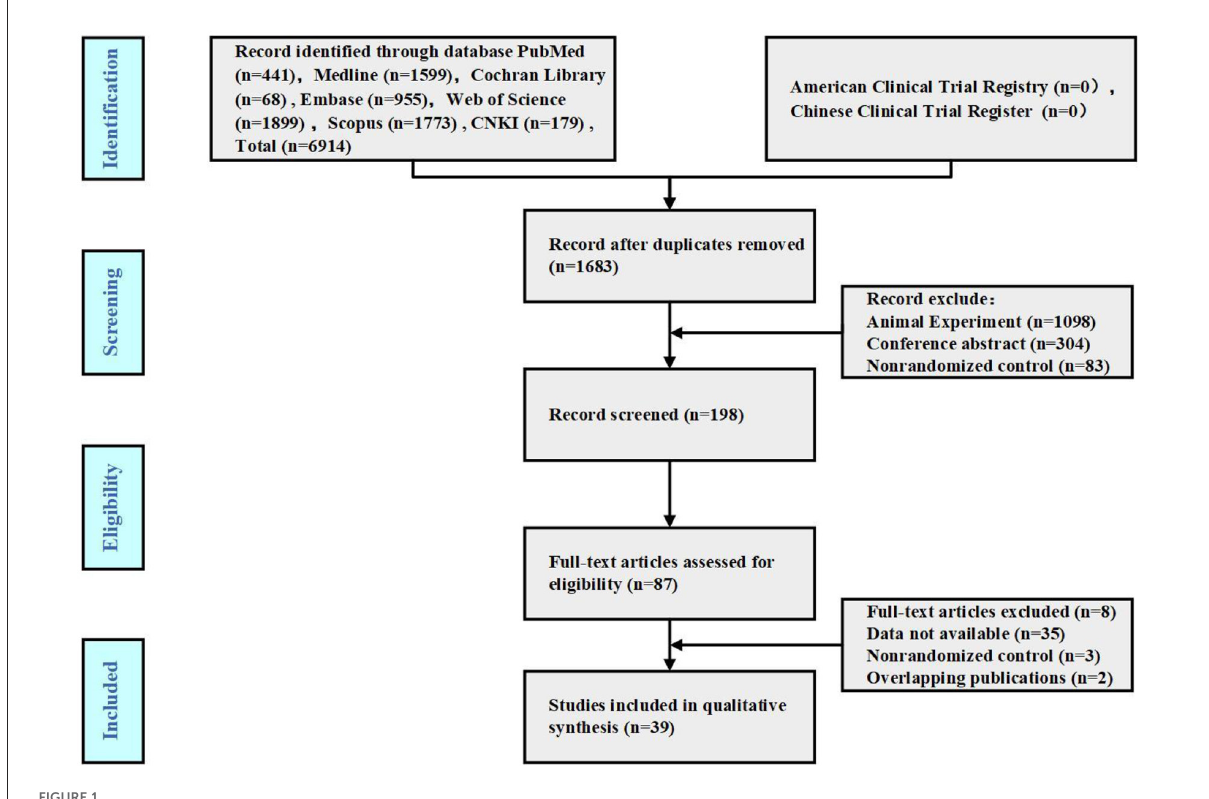
FIGURE1 Study flow